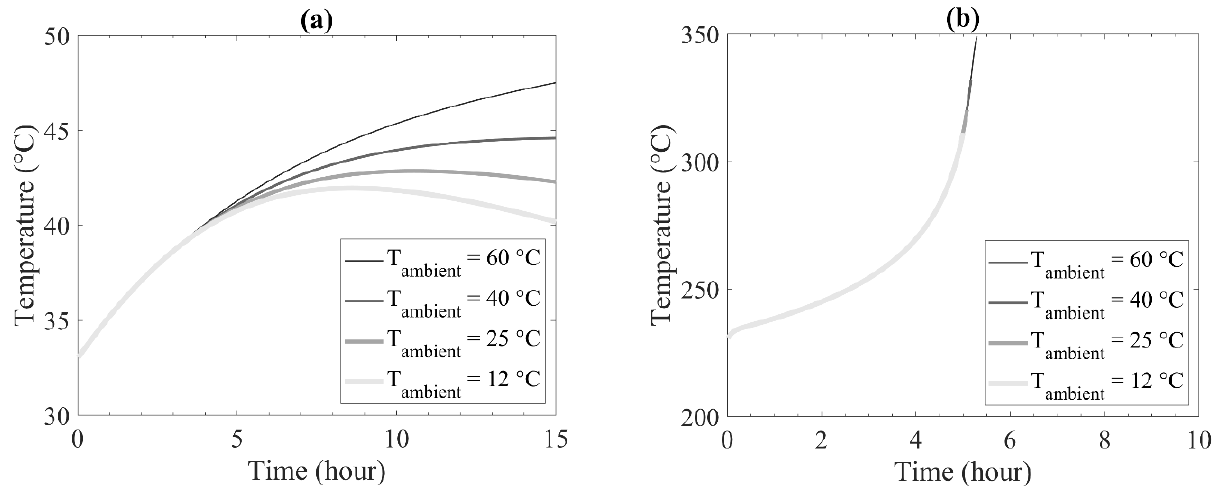
Figure 8. Effects of ambient temperature on the temperature at the center of the container with the storage conditions of ρ c ,0 = 200 kg m − 3 and H container = 1 m: ( a ) initial char temperatures of 33 ◦ C; ( b ) initial char temperatures of 230 ◦